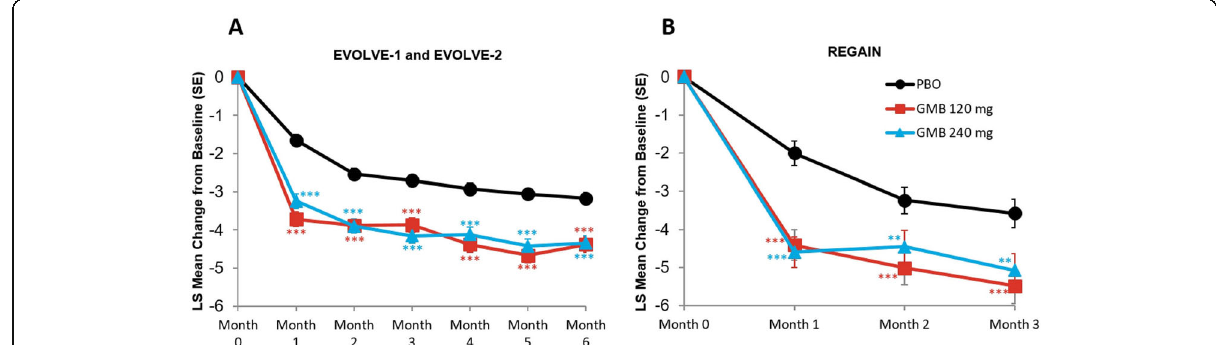
Fig. 5 Monthly mean change in moderate-to-severemigraine headache days. ** p ≤ 0.01 vsPBO; *** p ≤ 0.001 vs PBO. GMB,galcanezumab; LS, least squares; PBO, placebo; SE, standard